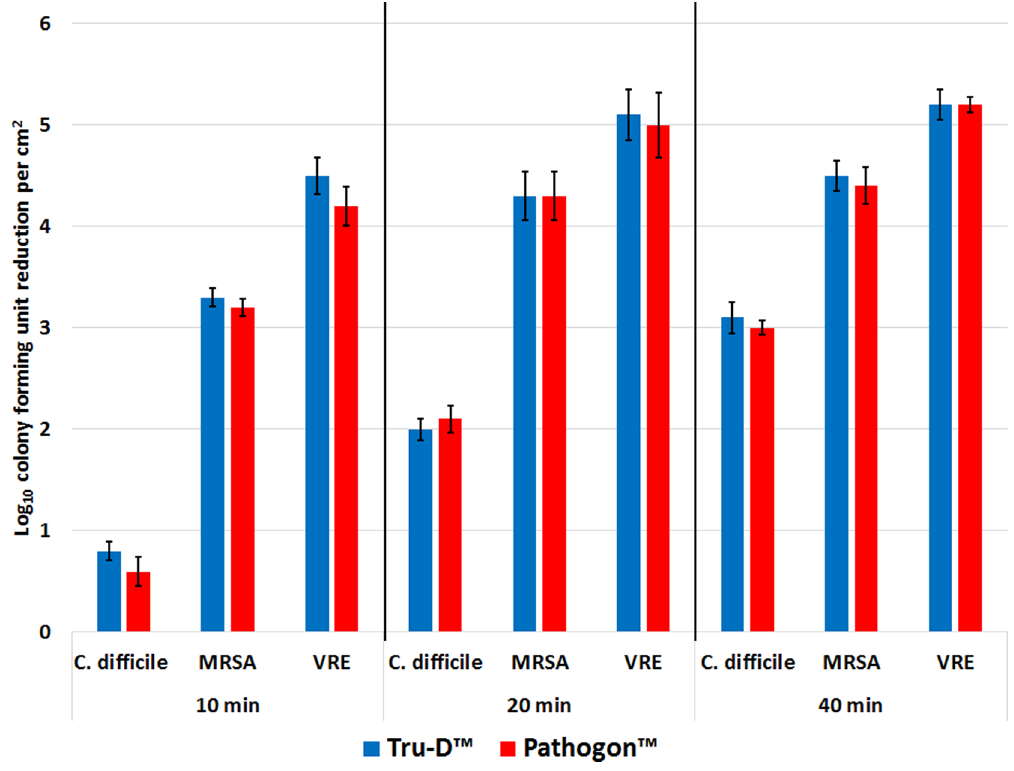
Figure 5. The effect of radiant dose on the efficacy of the UV-C devices. The log 10 CFU reduction/cm 2 of C.difficile spores, MRSA, and VRE after receiving increasing timed doses of irradiation delivered by the UV-C devices. Carriers contained 6 log 10 CFU of each pathogen. The carriers were irradiated for 10, 20, 40 minutes at a distance of 4 feet from the Tru-D or Pathogon device. The means of the data from experiments conducted in triplicate are presented. Error bars indicate standard